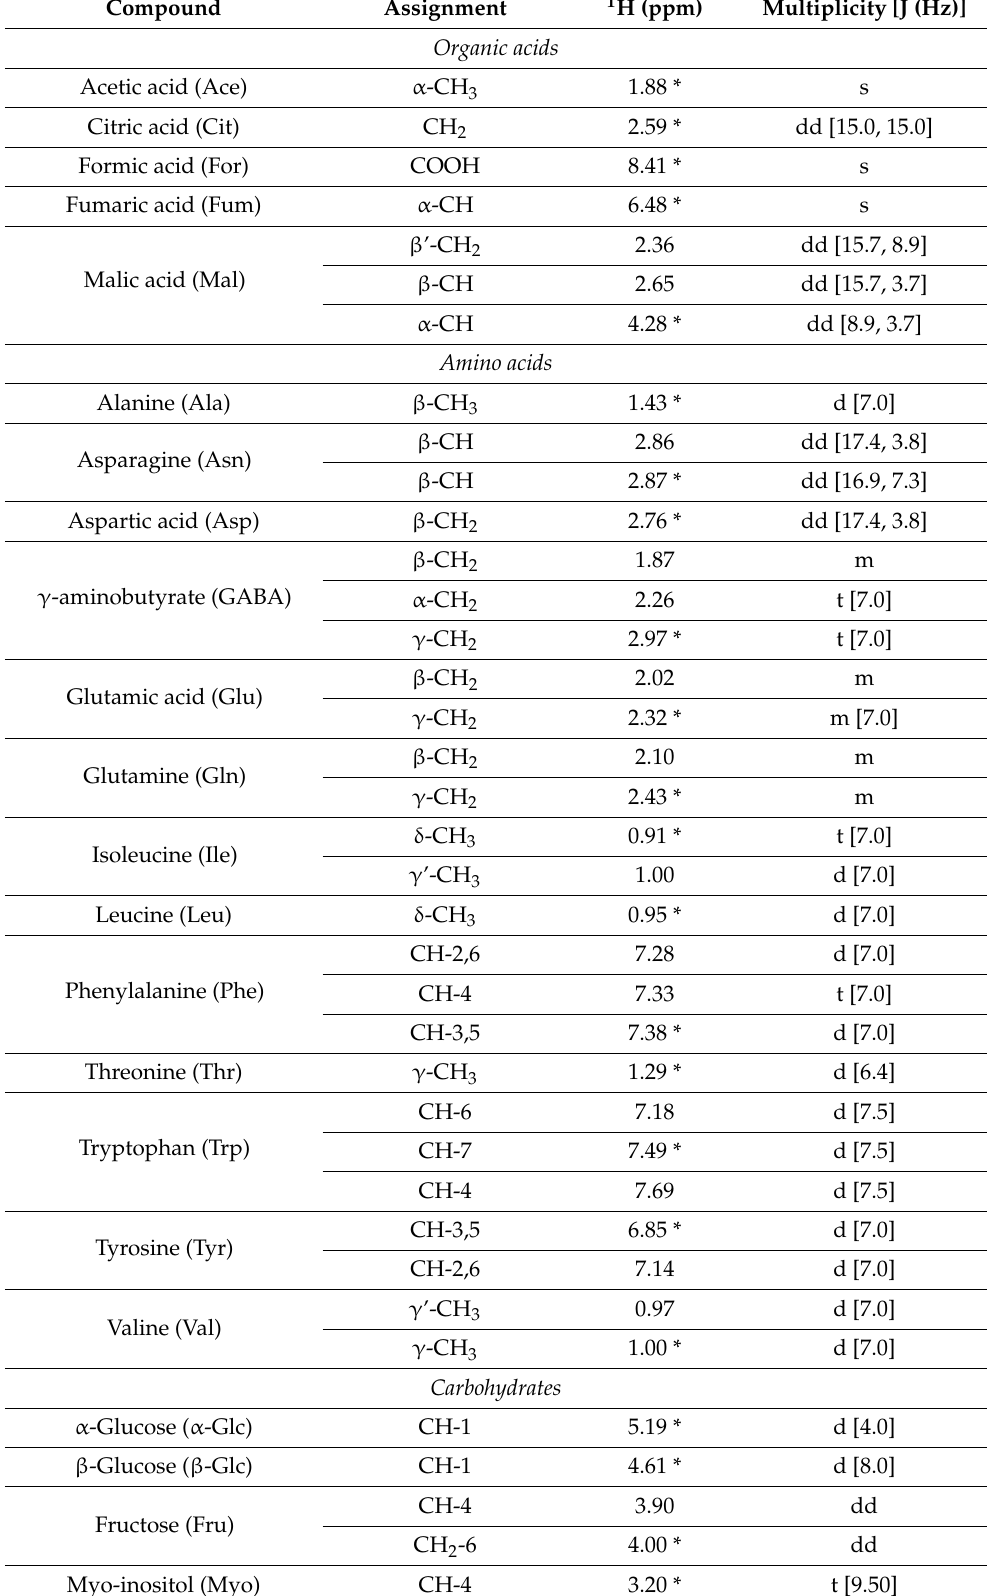
Table 2. 1 H NMR chemical shifts, assignment, and multiplicity at 600 MHz in D 2 O of the metabolites detected in all analyzed polar extracts of L. sativa